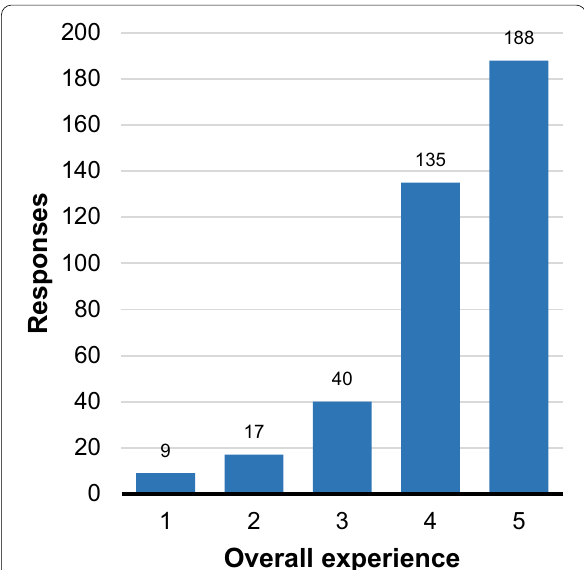
Fig. 5 Satisfaction of respondents with the overall experience with radiological services in the last 2 years (1 satisfied)